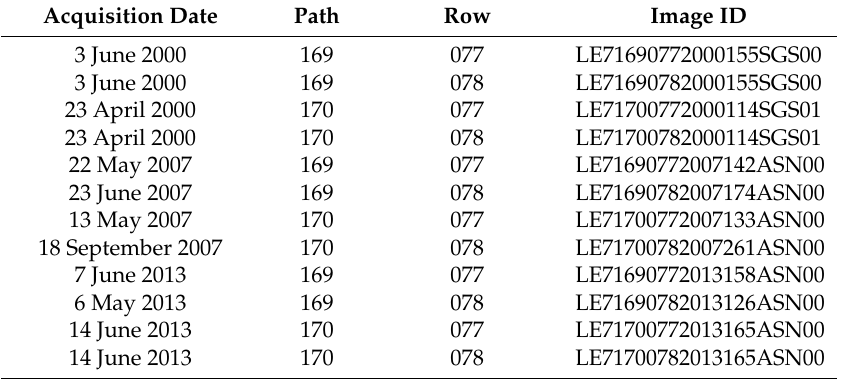
Table 2. Land cover classification scheme according to Anderson et al. [30].